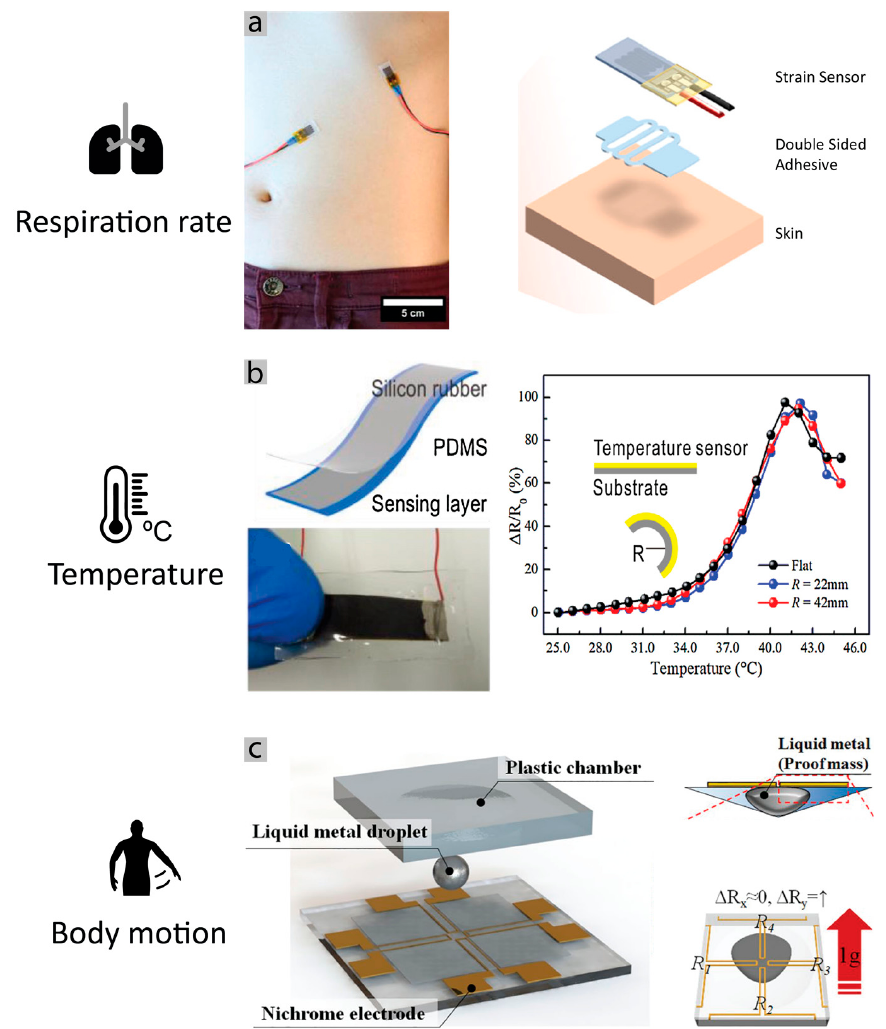
Figure 11. Respiration rate, temperature and motion sensors. ( a ) Respiration rate sensor using two small perpendicular strain sensors on the abdomen. Adapted with permission from [90]. ( b ) High resolution flexible small temperature sensor, based on Poly(ethylene oxide) (PEO) and graphite material, encapsulated with PDMS and silicon rubber. Adapted with permission from [93] (on the right, the performance upon bending). ( c ) Dual-axis accelerometer using a liquid metal ball as a proof mass, moving inside an encapsulation. Adapted with permission from [100].